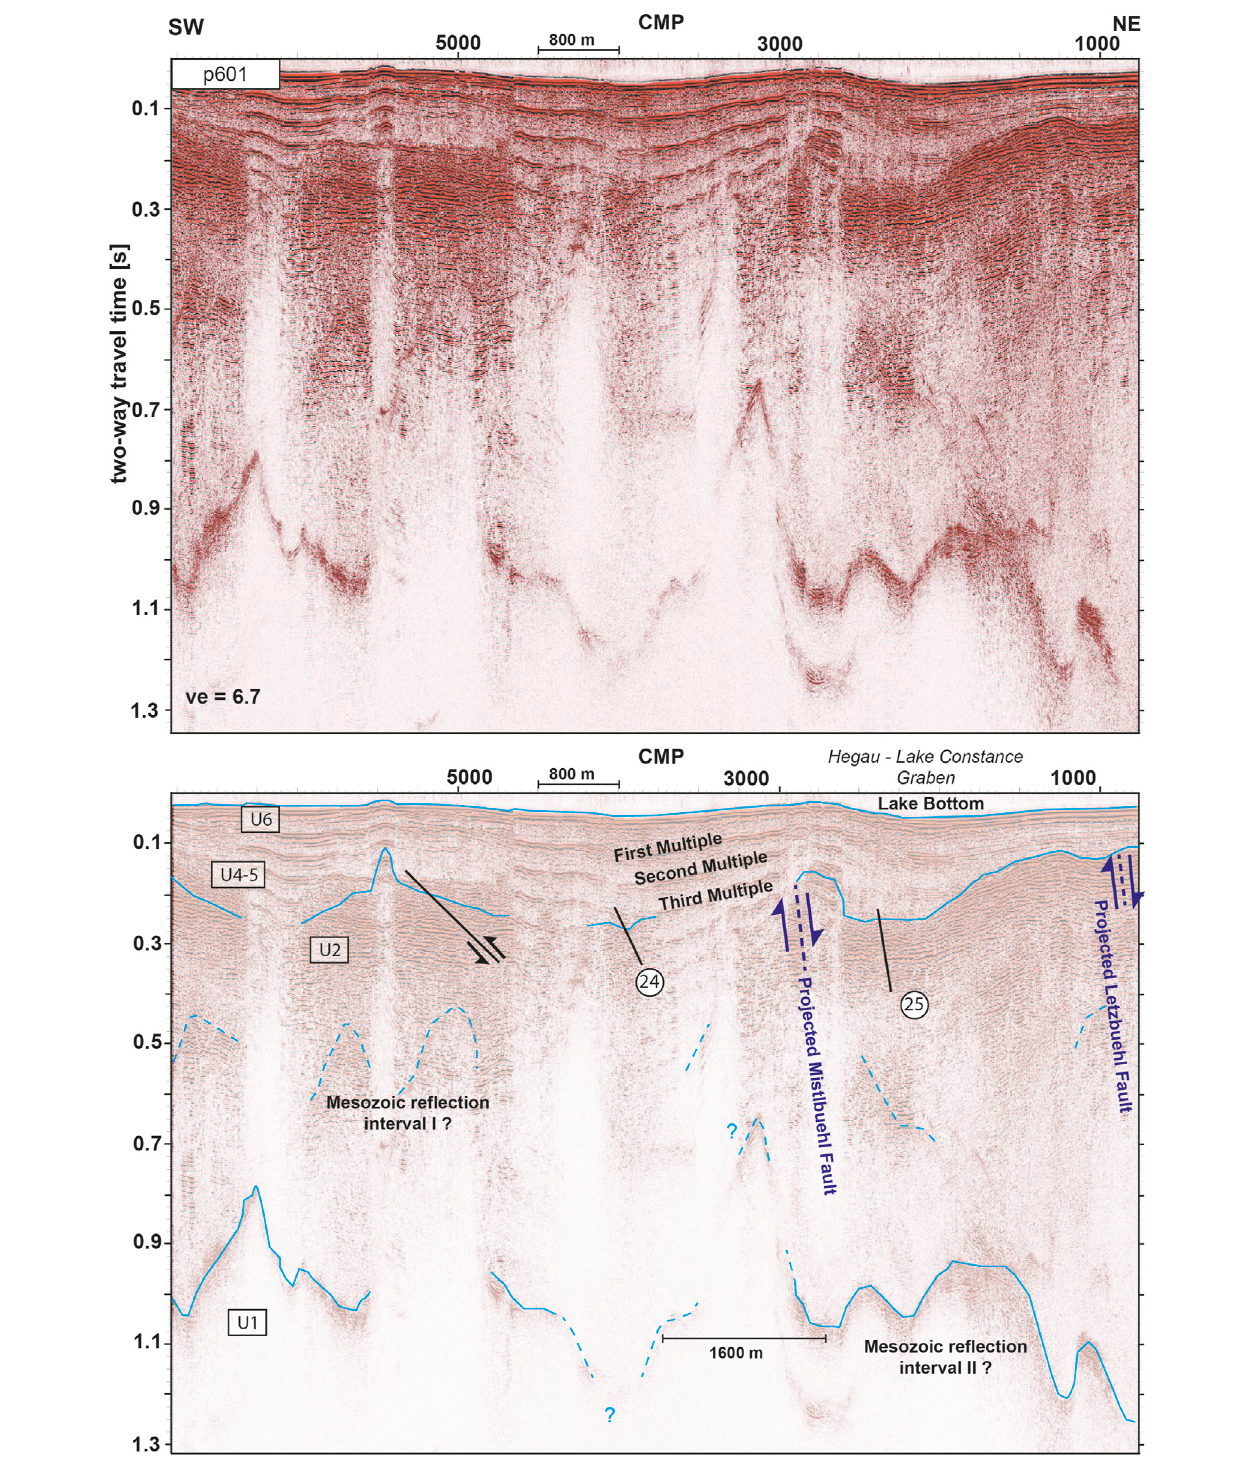
FIGURE 5 | top: Seismic line p601 in Untersee Basin (location in Figure 3 ). Bottom: Interpretation of line p601. U3 is not recognizable. Faults are projected from Figure 6 and the pro fi le in Figure 1 . The northeastern faults are part of fault planes FID 24 and FID 25 (circled numbers, see Supplementary Table S5 for details). Re fl ections at ∼ 600 and 1,000 ms may belong to individual Mesozoic bedrock packages of unit U1.